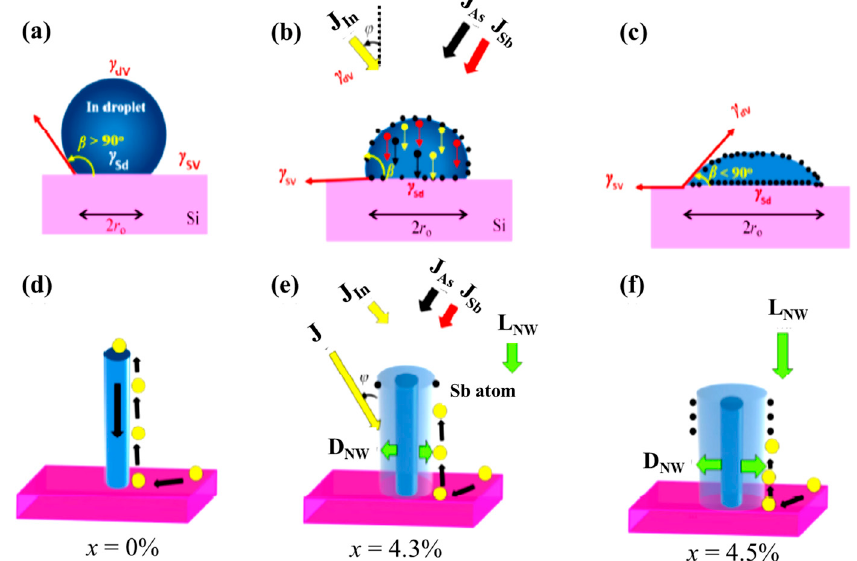
Figure 4. Schematic illustration of the e ff ect of Sb surface segregation on the geometry of indium droplet ( a – c ) and suppression of InAs NWs axial growth ( d – f ). J I n , J Sb , and J As denote the In, Sb, and As flux, respectively. The balance of forces acting on a droplet placed on a substrate are also shown with γ dv , γ sd , γ sv representing the surfaces energies at the droplet–vapor, solid–droplet, and solid–vapor interface, respectively, and β is the contact angle between droplet and substrate. Note that the NW dimensions are not drawn to scale and do not represent the extent of Sb-induced modification to the NW geometry. Reproduced with permission from [32]. Copyright 2014, Springer Nature.